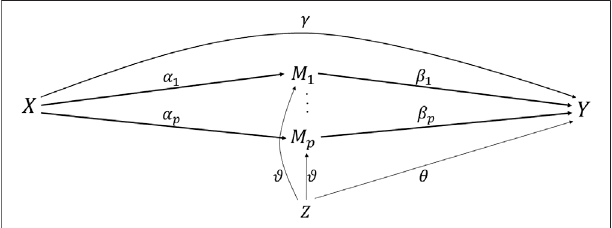
FIGURE 1 | Direct acyclic graph with the exposure, outcome, and high- dimensional